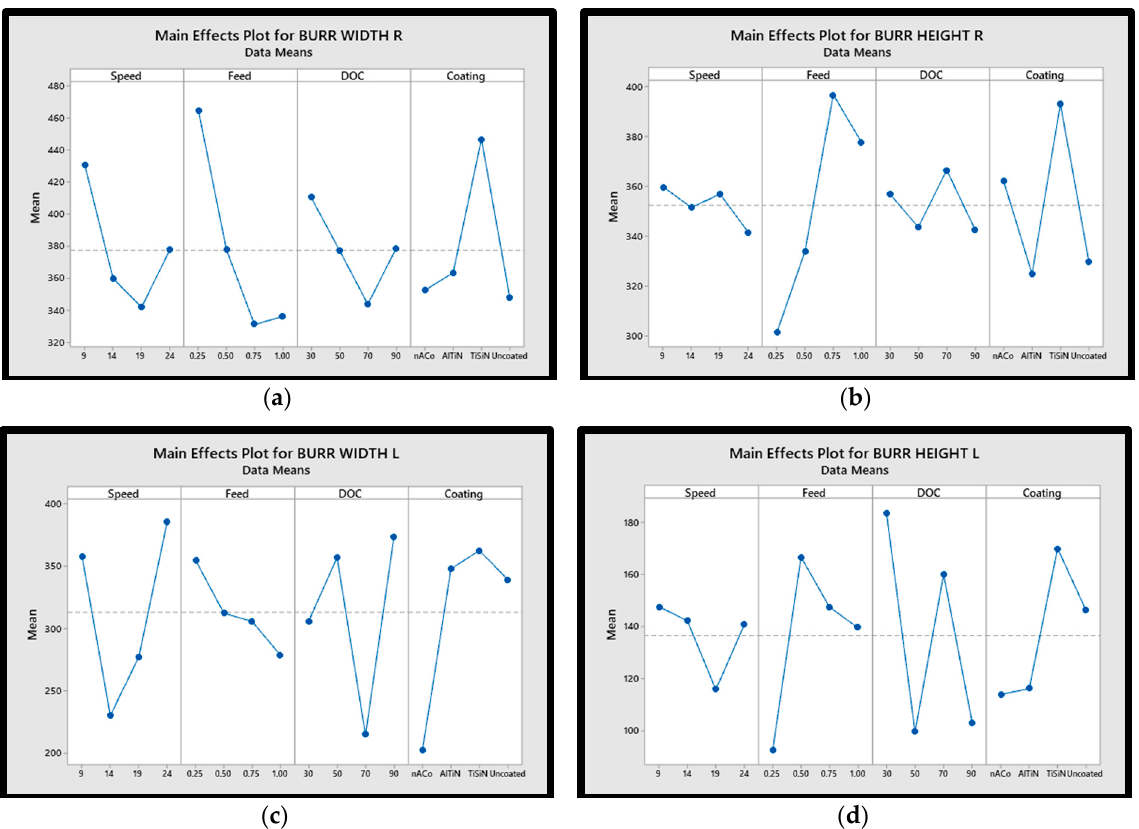
Figure 5. Main effects plots of ( a ) burr formation width down milling, ( b ) burr formation height down milling, ( c ) burr formation width up milling, ( d ) burr formation height up milling.